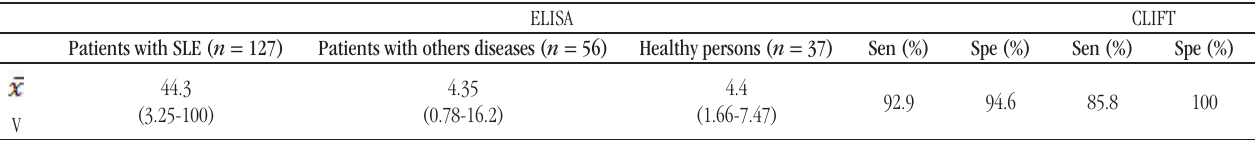
taBLE − ELISA and CLIFT results in patients with SLE, patients with other diseases and healthy persons ELISA CLIFT Patients with SLE ( n = 127) Patients with others diseases ( n =